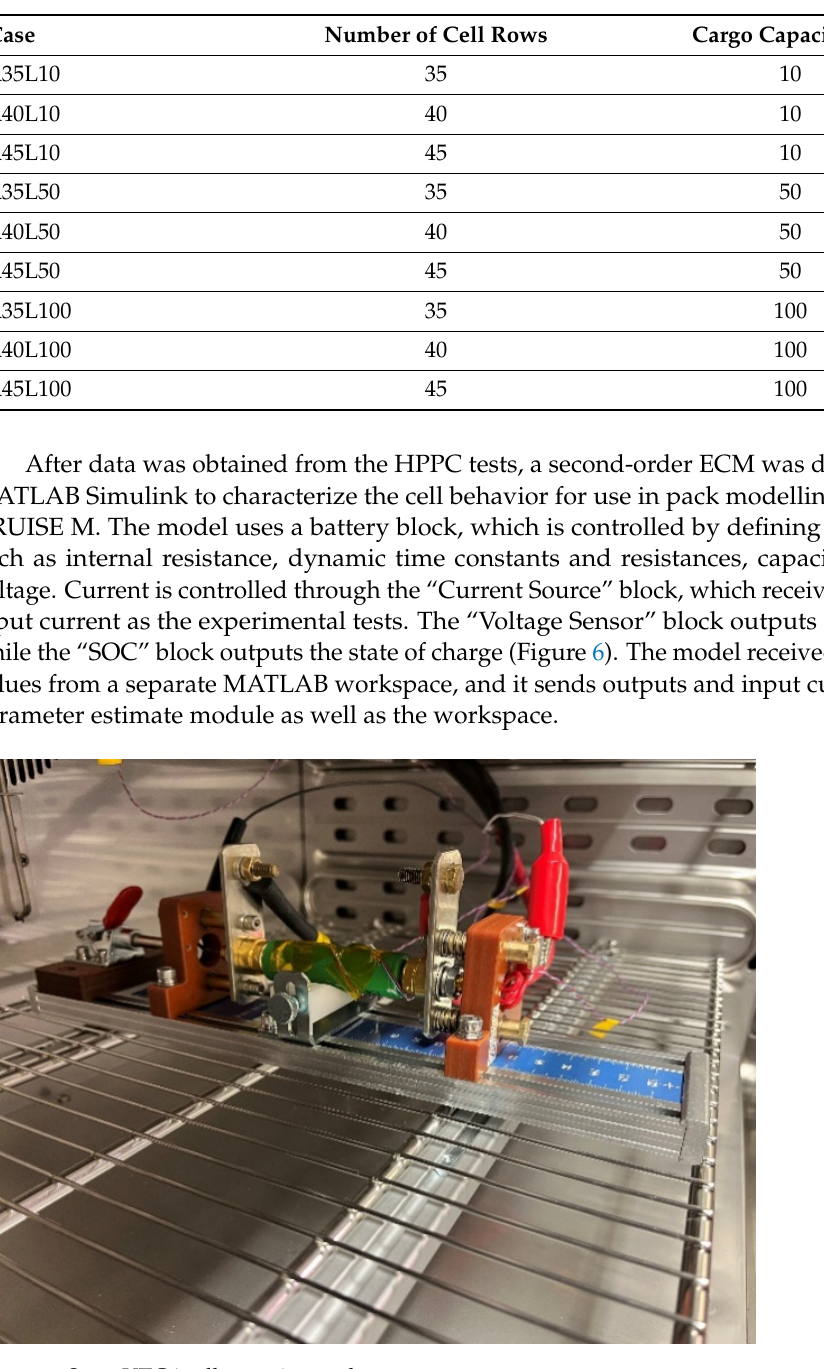
Table 4. Case scenarios for parametric study performed.